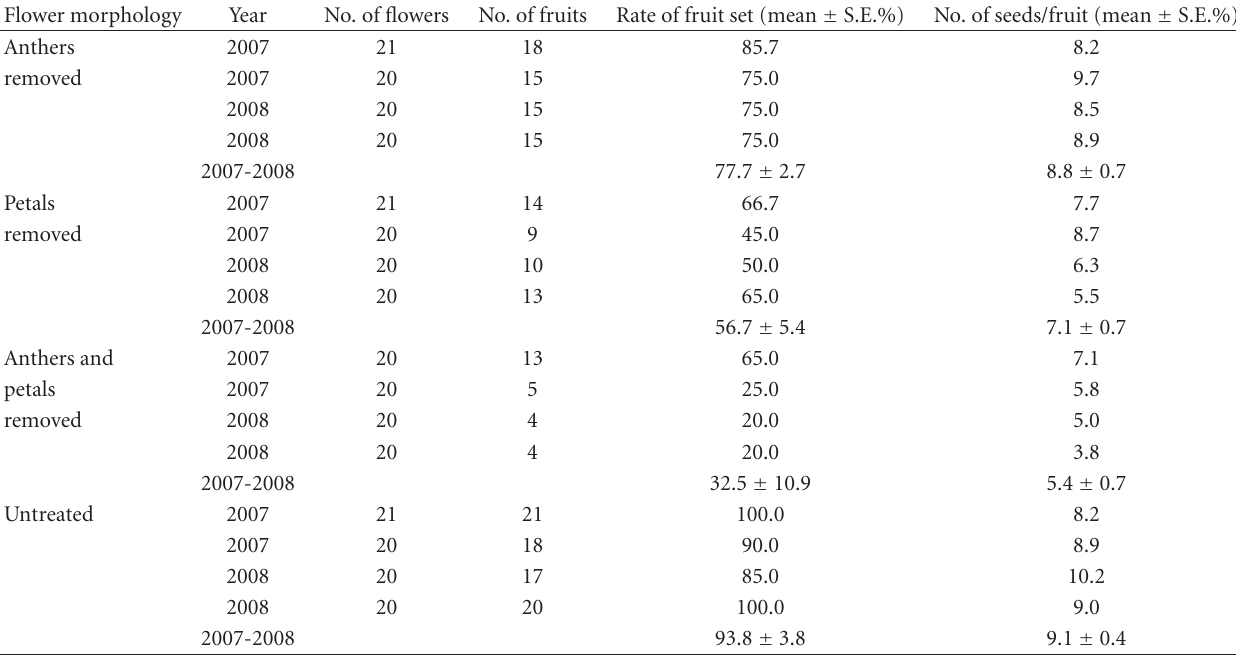
Table 1: Fruit set of “Fuji” fruit formed by open-pollination.